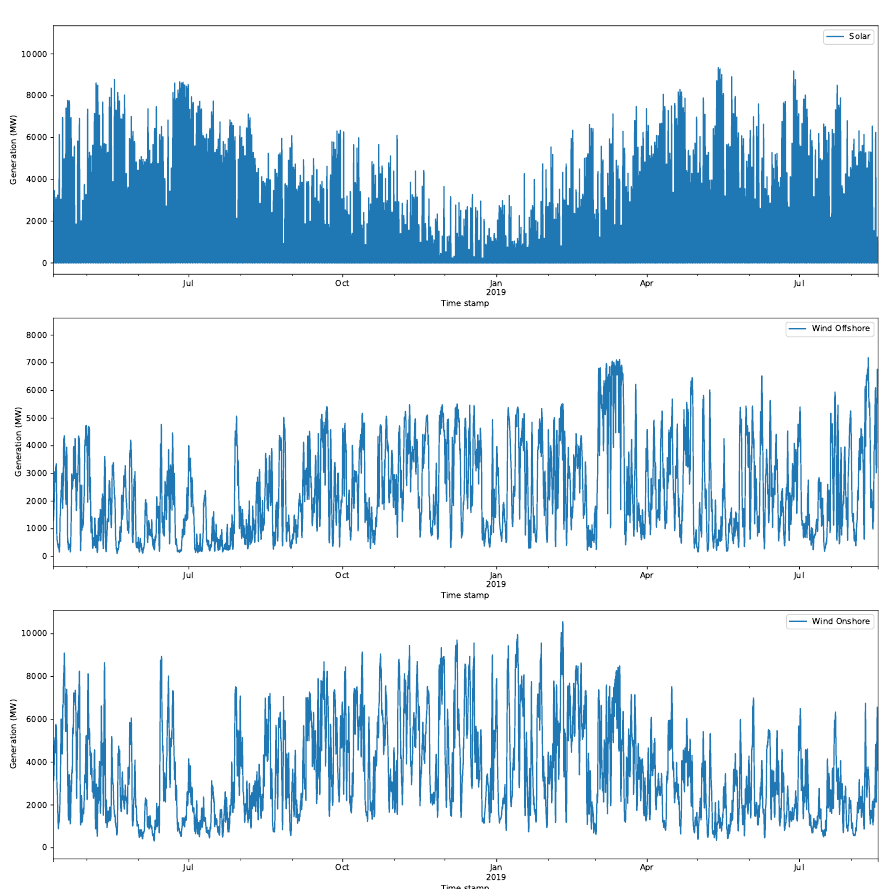
Figure 5. Day-ahead forecasts for the solar ( top ), offshore wind ( middle ), and onshore generation ( bottom ) for the period of 11 April 2018 to 17 August